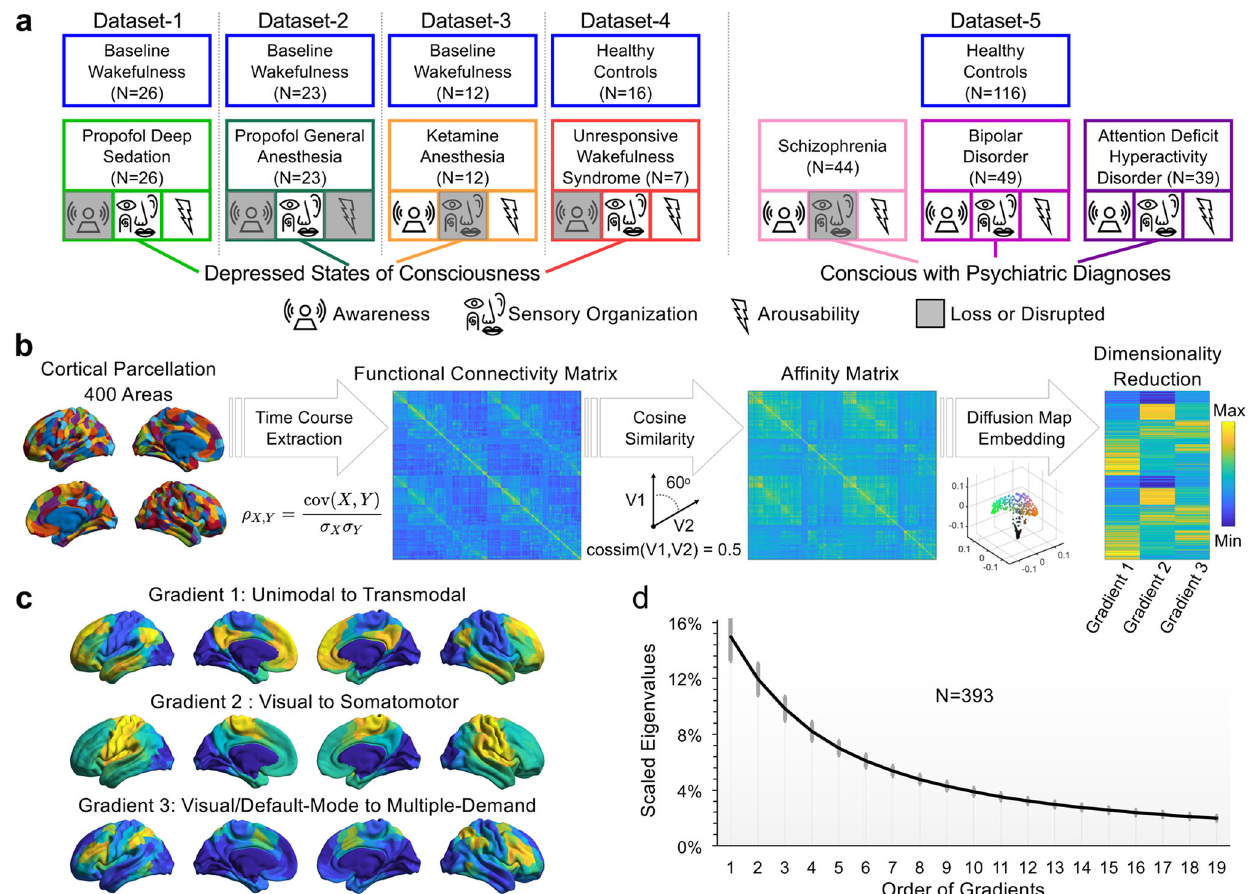
Fig. 2 | Datasets description and cortical gradient calculation. a Five fMRI datasets consist of participants and patients with normal wakefulness (baseline/ healthycontrols)anddepressed(oraltered)statesofconsciousness. b Anoverview of cortical gradient analysis. The fMRI time courses were extracted from 400 cortical areas according to a brain parcellation scheme 26 . A 400×400 functional connectivity matrix was calculated for each participant and each condition. A normalized cosine angle af fi nity matrix was calculated to capture the similarity of connectivity pro fi les between cortical areas. Cortical gradients were computed